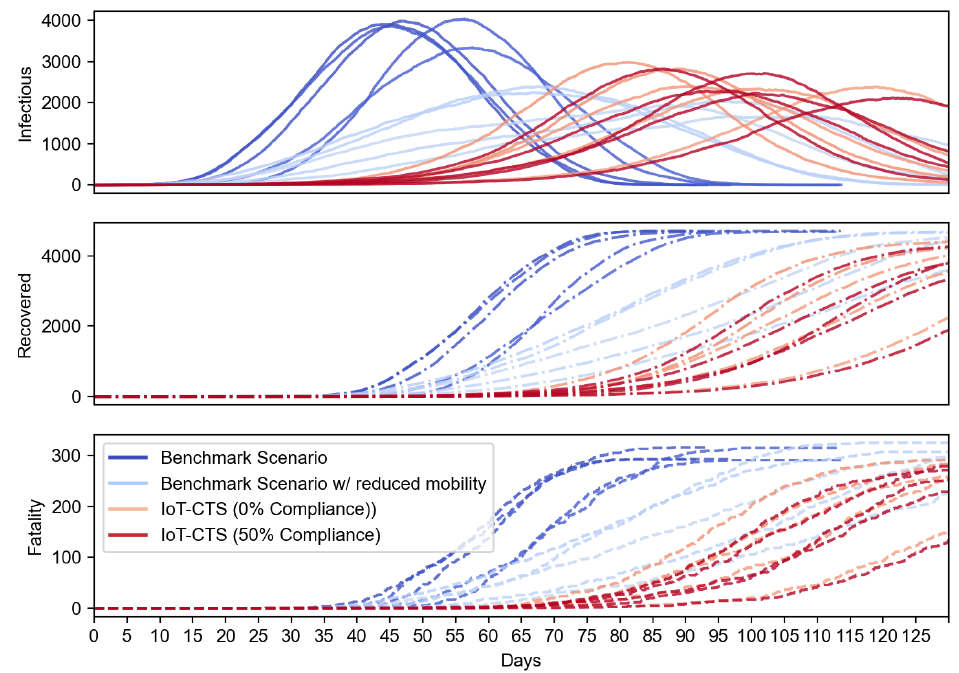
Figure 4. Epidemiological performance between benchmark solutions and IoT-CTS solutions.